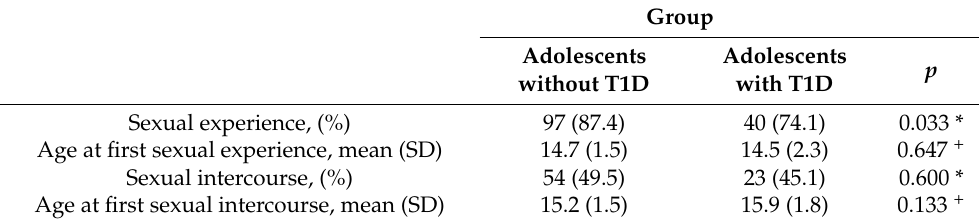
Table 1. Sexual activity of the two study groups.